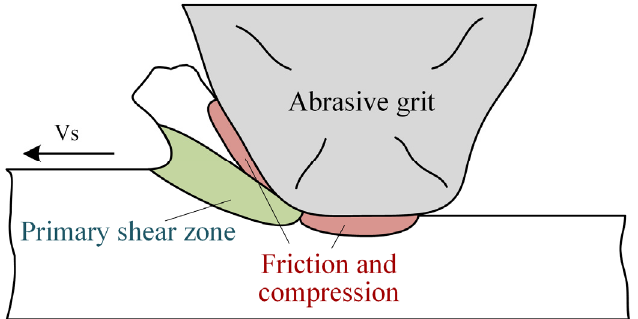
Figure 13. Schematic showing the main sources of grinding heat.